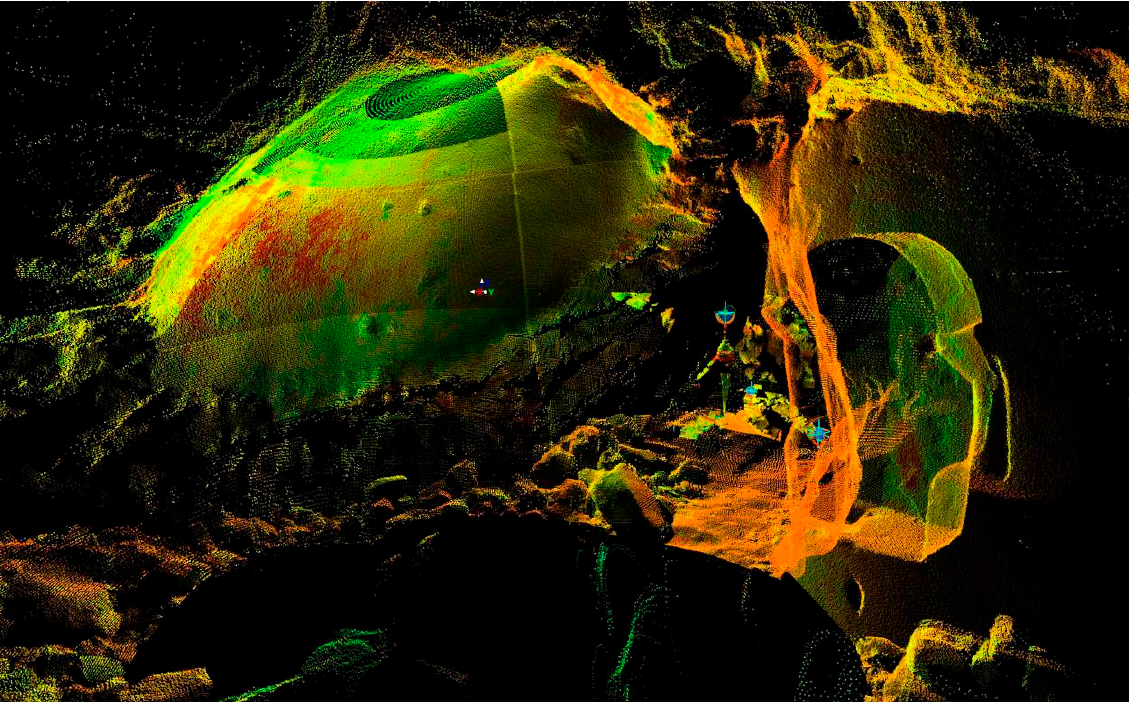
Figure 13. The 3D model of the biggest room close to the entrance: the altar is visible on the right while the ceiling with paintings is visible on the left.